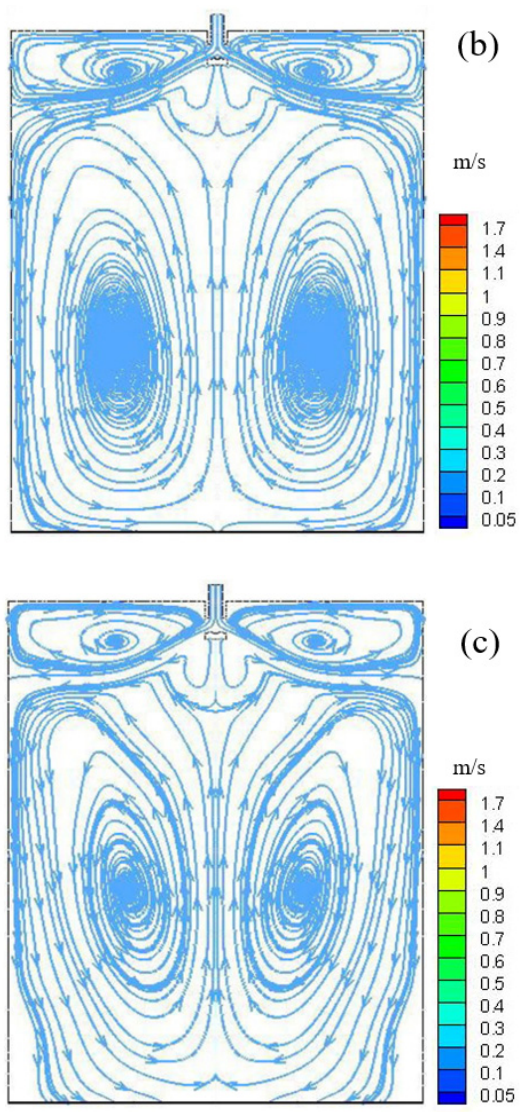
Figure 6. Trajectory line of molten steel: ( a ) 180 mm; ( b ) 200 mm; and ( c ) 220 mm. Table 3. Whirlpool core positions and strike locations under different immersion depths.